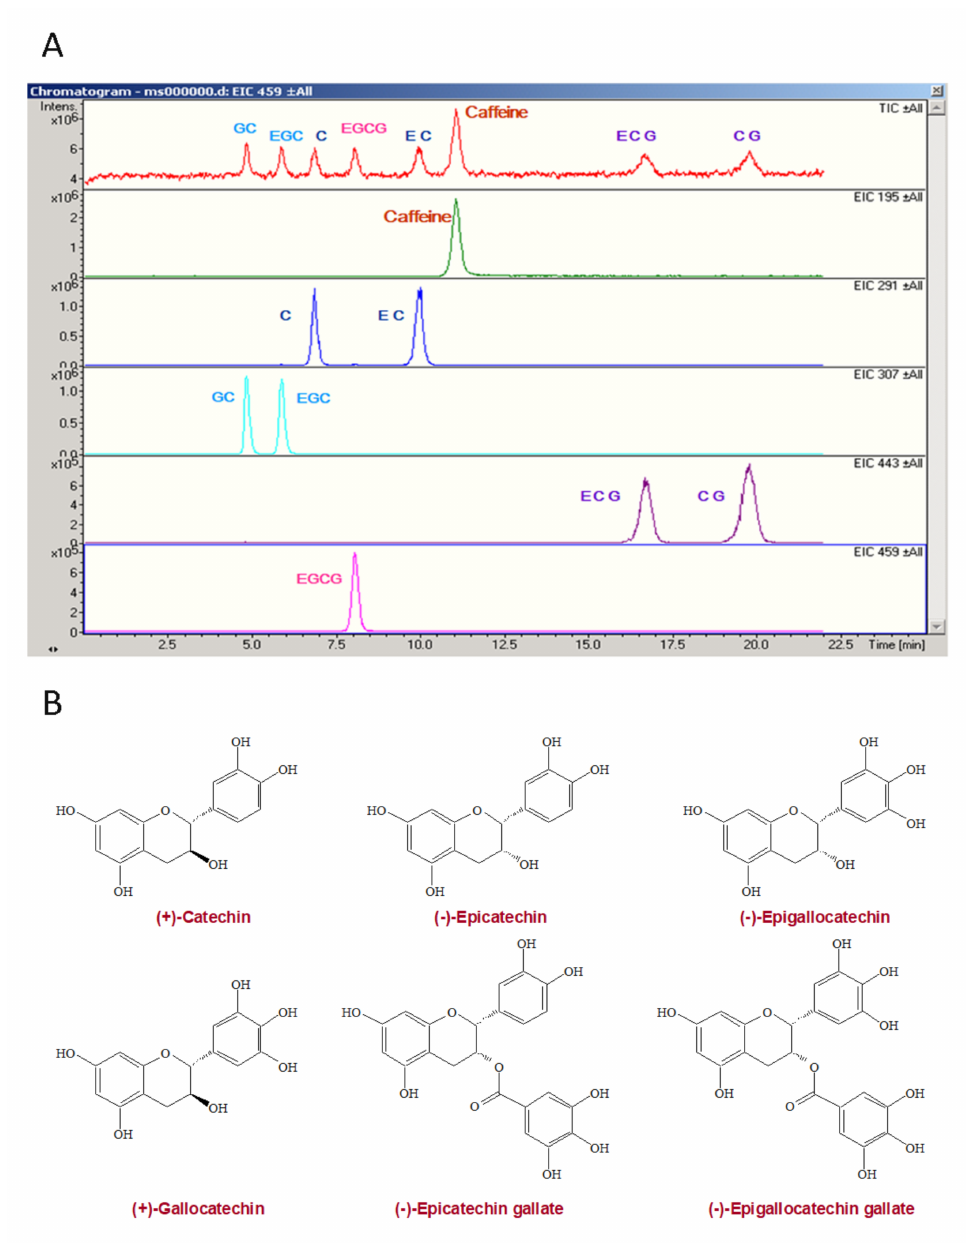
Figure 1. The HPLC analysis of green tea extracts catechins ( A ) and chemical structures of catechins ( B ). C, catechin; EC, epicatechin; GC, gallocatechin; CG, catechin gallate; EGC, epigallocatechin; CAF, caffeine; ECG, epicatechin gallate; EGCG, epigallocatechin